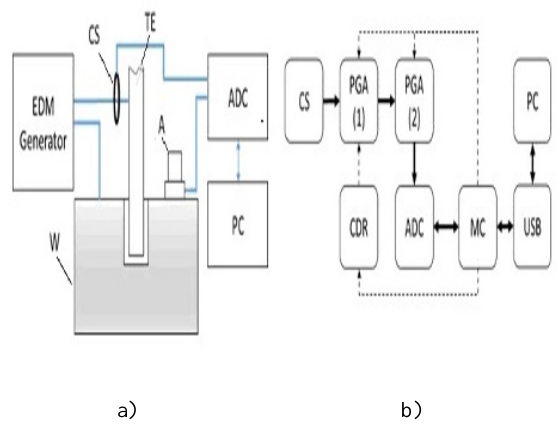
Fig. 7. Spectra of VA signals over 12 seconds prior to the breakage (1) and over the last second of the operation (2); the inset shows records of VA signal in 2 kHz and 16 kHz octave bands